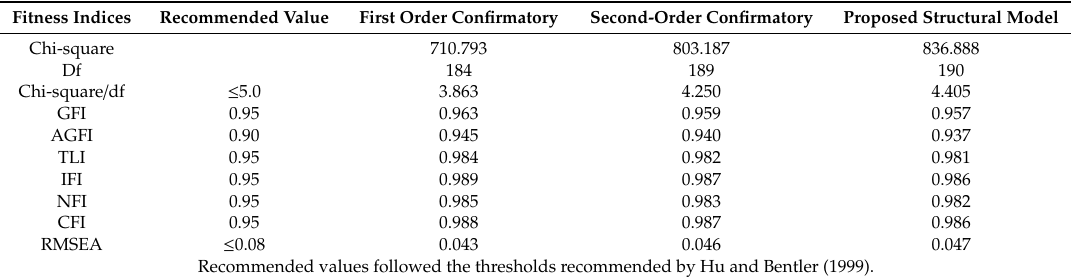
Table 5. Model fitness indices.